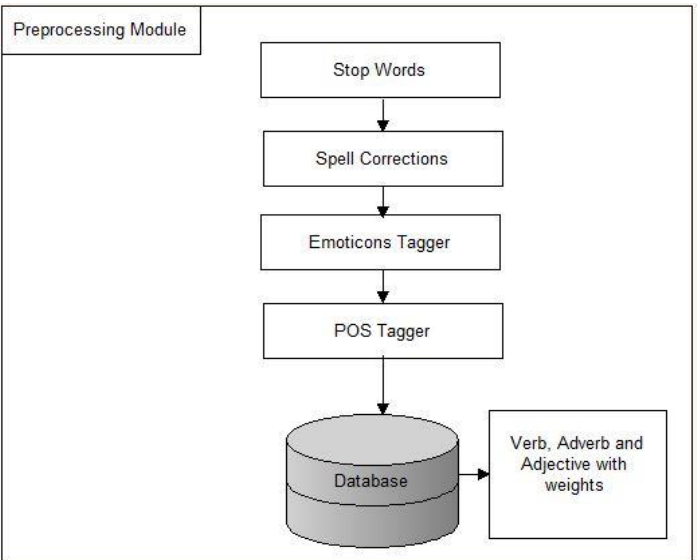
Figure 2. Pre-Processing